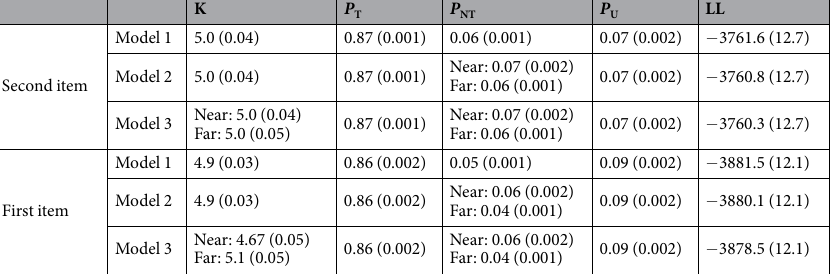
Table 4. Estimates from the mixture models for Experiment 3, calculated using a model in which neither K nor P NT could differ between Near and Far conditions (Model 1), a model in which only P NT could differ (Model 2) and a model in which both K and P NT could differ (Model 3). The 95% confidence interval is shown in parentheses, which was found by bootstrapping the data 100 times. LL denotes the log